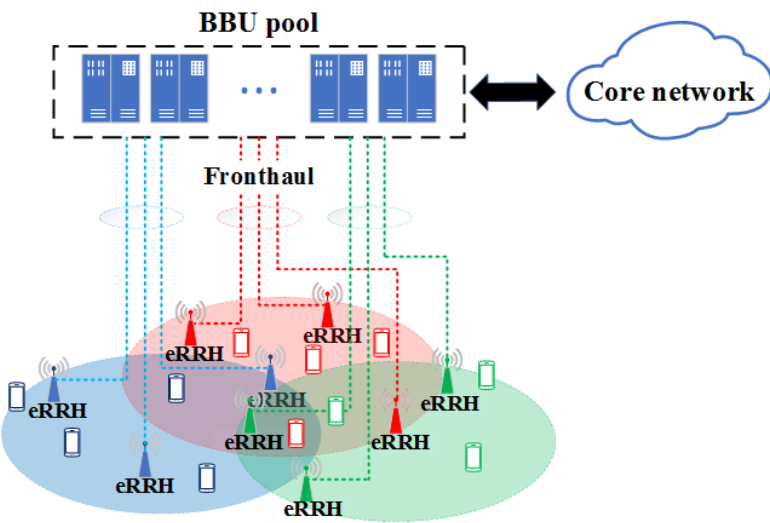
Figure 1. An architecture of F-RAN scheduling framework. The UEs with the same preference are denoted by the same color and the dotted loops of different colors denote the areas where the corresponding preferences are